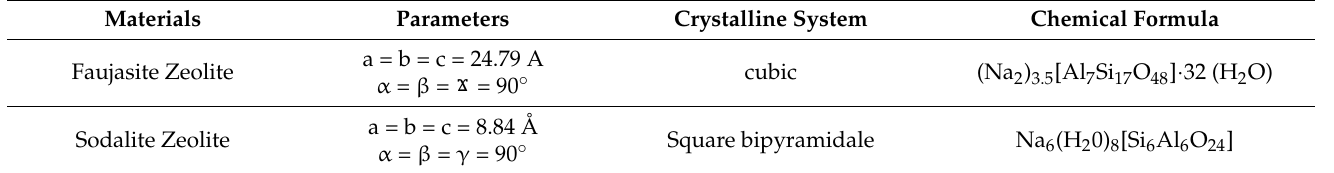
Table 2. Crystal parameters of the synthesized zeolites.